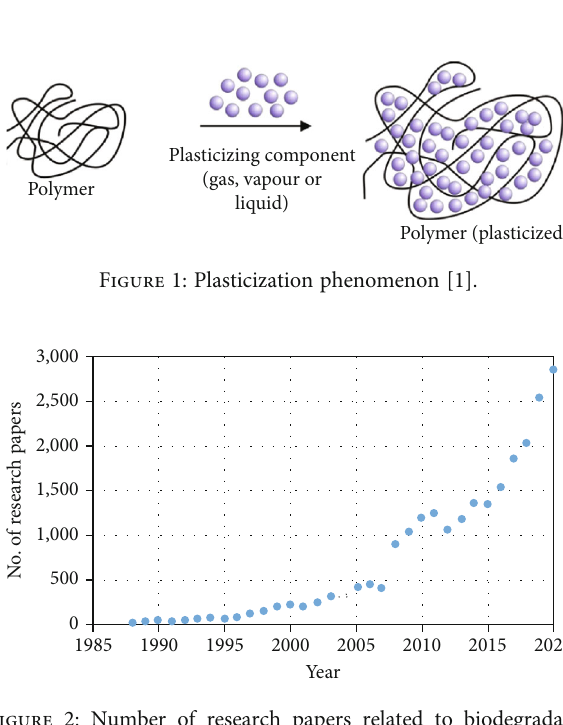
Figure 2: Number of research papers related to biodegradable plastics.